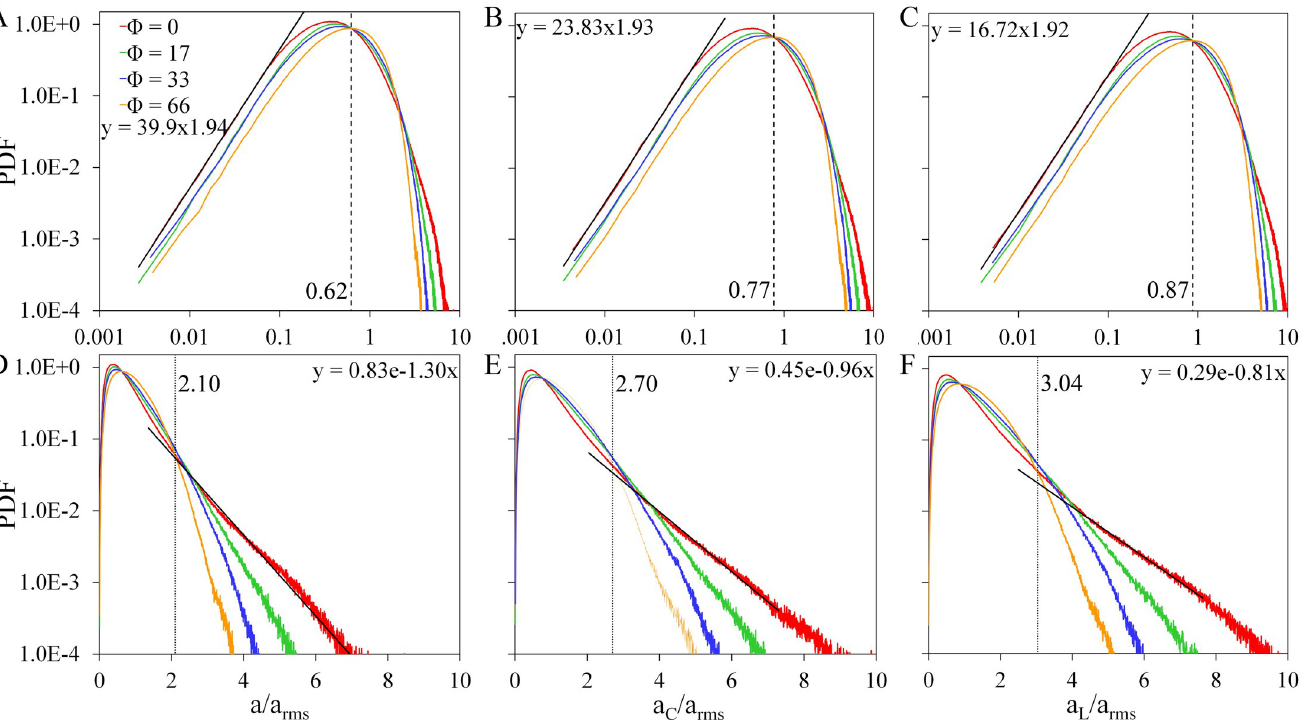
Fig 6. PDF of acceleration magnitude when Re λ = 59. (A-C) Log-log plots of the acceleration magnitude PDF where the vertical dashed line corresponds to the location of the first cross-over. (D-F) Log-linear plots of the the PDFs where the vertical dotted lines corresponds to the location of the second cross-over. Black solid lines are the estimated